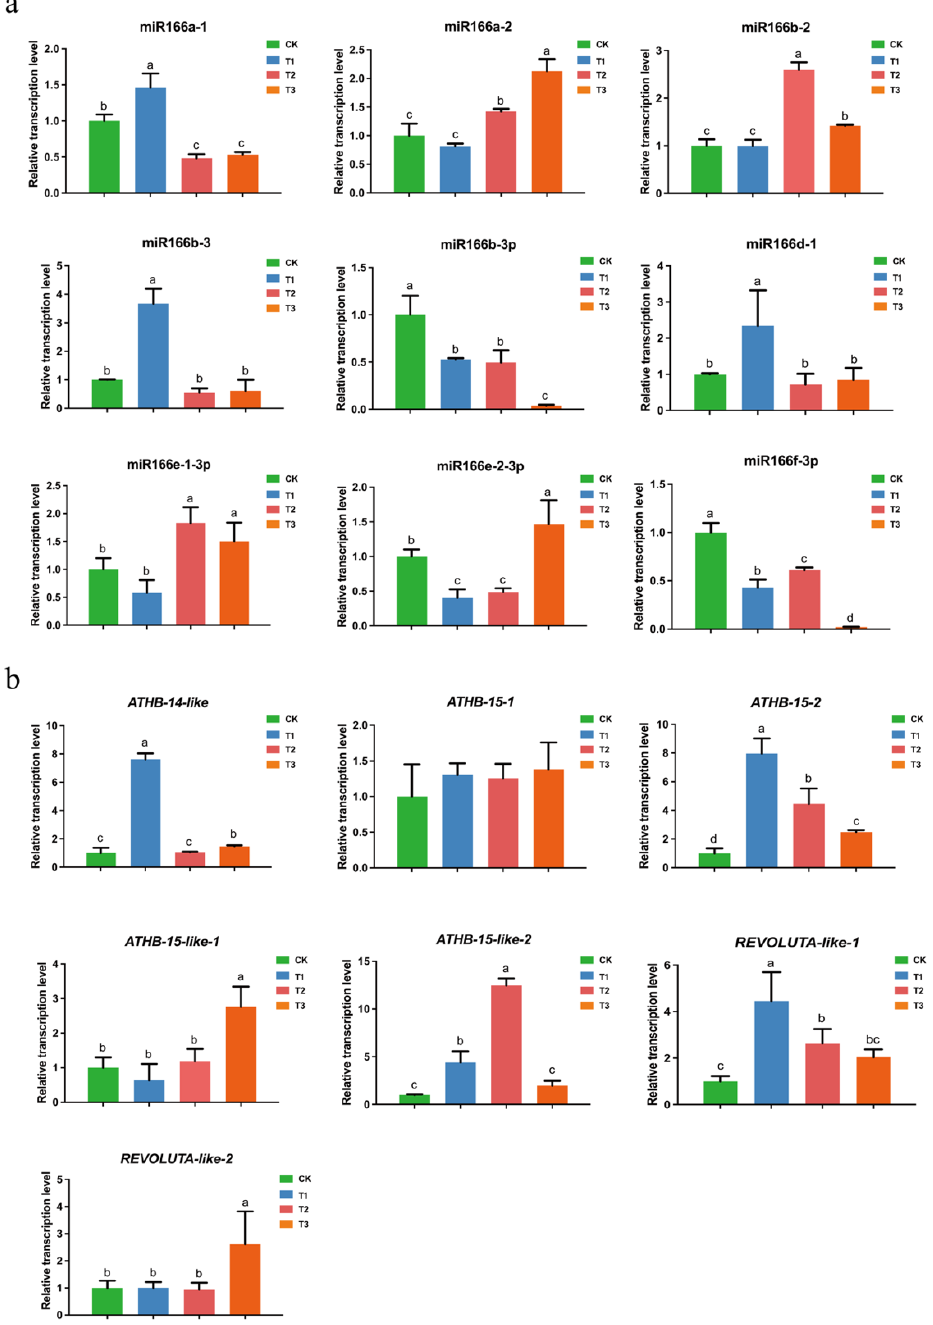
Figure 8. ( a ) Transcription patterns of the miR166s under different drought degrees. ( b ) Transcription patterns of the targets under different drought degrees. Data were the mean of three independent replicates ± standard deviation (SD). Different lowercase letters indicate significant differences at different drought degrees ( p < 0.05).